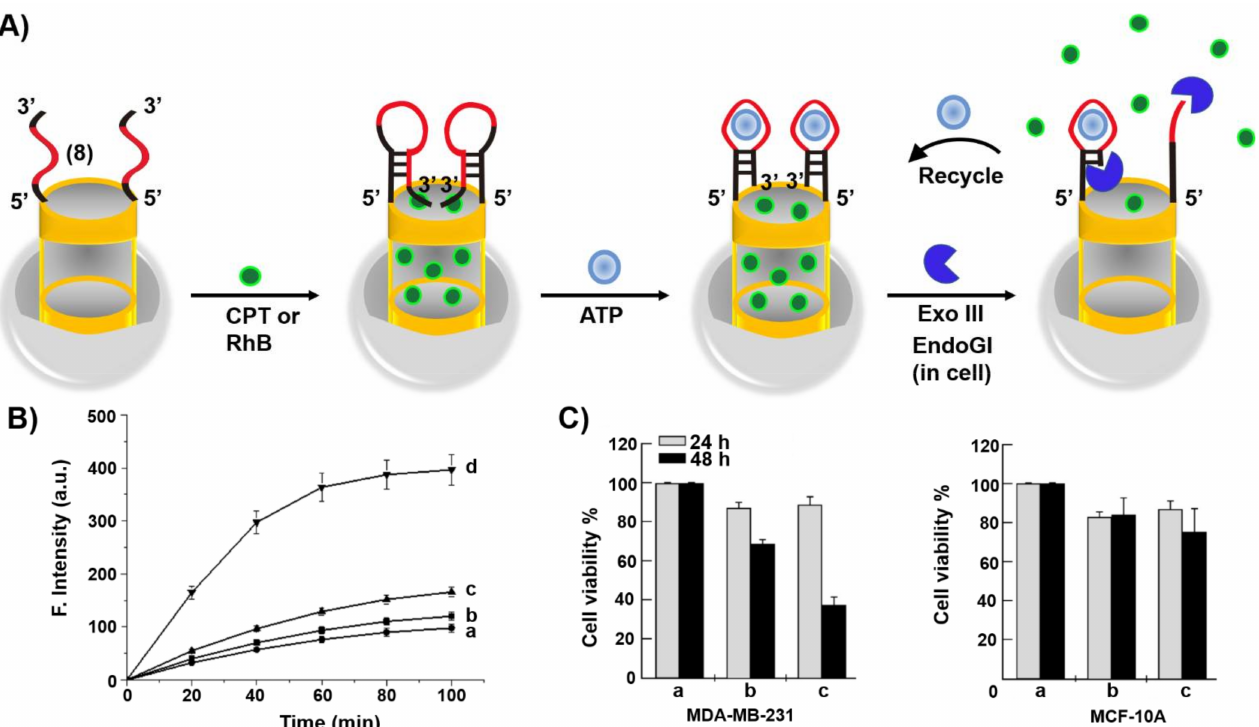
Figure 9. ( A ) Hairpin ( 8 )-gated, camptothecin (CPT) loaded MP SiO 2 NPs for the ATP-driven and exonuclease III (Exo III)-amplified release of loads. The hairpin ( 8 ) contains the ATP aptamer sequence in a caged structure. In the presence of ATP, the hairpin (8) is reconfigured into an ATP/ATP aptamer supramolecular structure that is cleaved by Exo III, leading to the degradation of the locks and the recycling of ATP for the further unlocking of the gate units (amplification step). ( B ) Time-dependent release of CPT from the ( 8 )-hairpin-caped NPs: a = in the absence of ATP and Exo III; b = in the presence of ATP (1 mM); c = in the presence of Exo III (0.5 U/ µ L); d = in the presence of ATP (1 mM) and Exo III (0.5 U/ µ L). ( C ) Cytotoxicity of the CPT-loaded MP SiO 2 NPs towards MDA-MB-231 breast cancer cells in comparison to normal epithelial MCF-10A breast cells. a = nontreated cells; b = cells treated with free CPT; c= cells treated with the CPT-loaded MP SiO 2 NPs. Reproduced with permission from ref. [161]. Copyright 2013 American Chemical